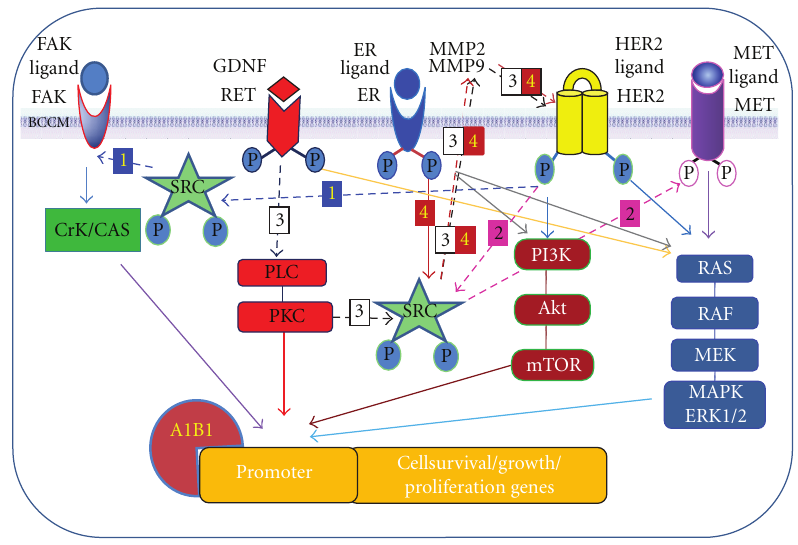
Figure 1: Growth pathways in breast cancer. Key receptors are shown phosphorylated upon ligand binding, a chemical change that triggers downstream growth and proliferation pathways. Receptor crosstalks between receptors are shown by dotted arrows that can be chased by numbers: 1: Her2-FAK, 2: Her2-Met, 3: ER-Her2, 4: Ret-Her2. BCCM: breast cancer cell membrane; MMP: matrix metalloproeinases; A1B1: ER coactivator. For details of signaling pathways see the